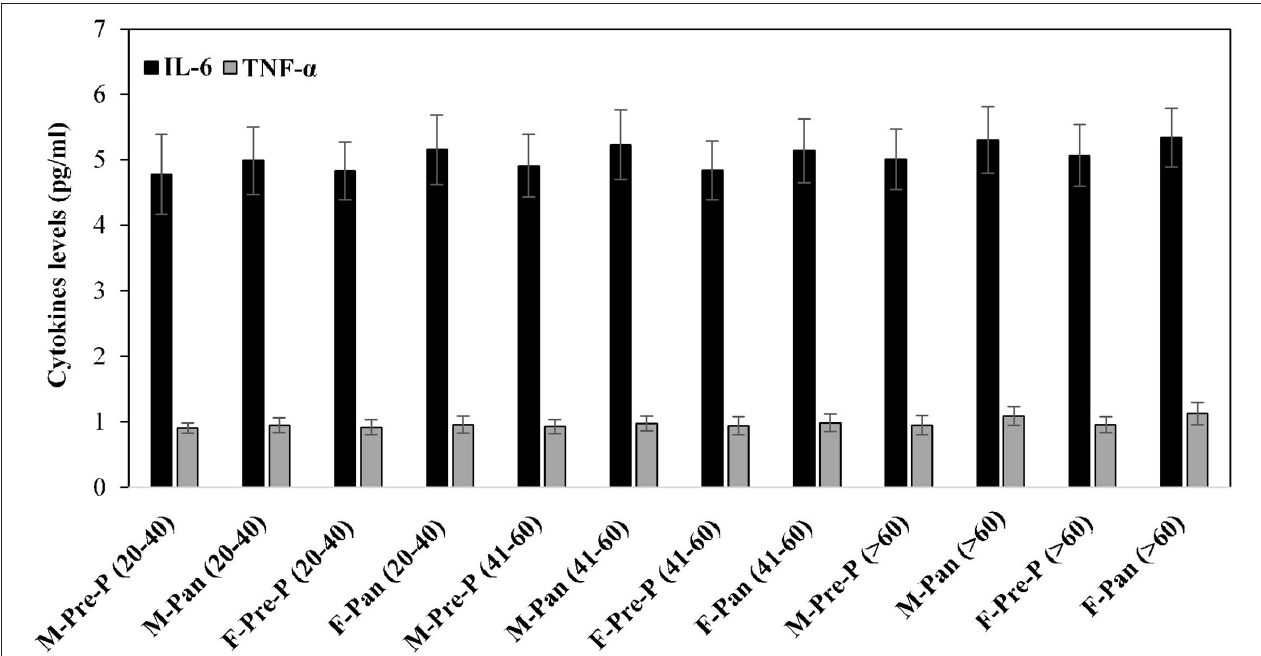
FIGURE 6 | Serum inflammatory cytokines TNF- α and IL-6 levels (pg/ml) were estimated from all the studied groups. All samples were in triplicates, and values are given as mean ± SD.